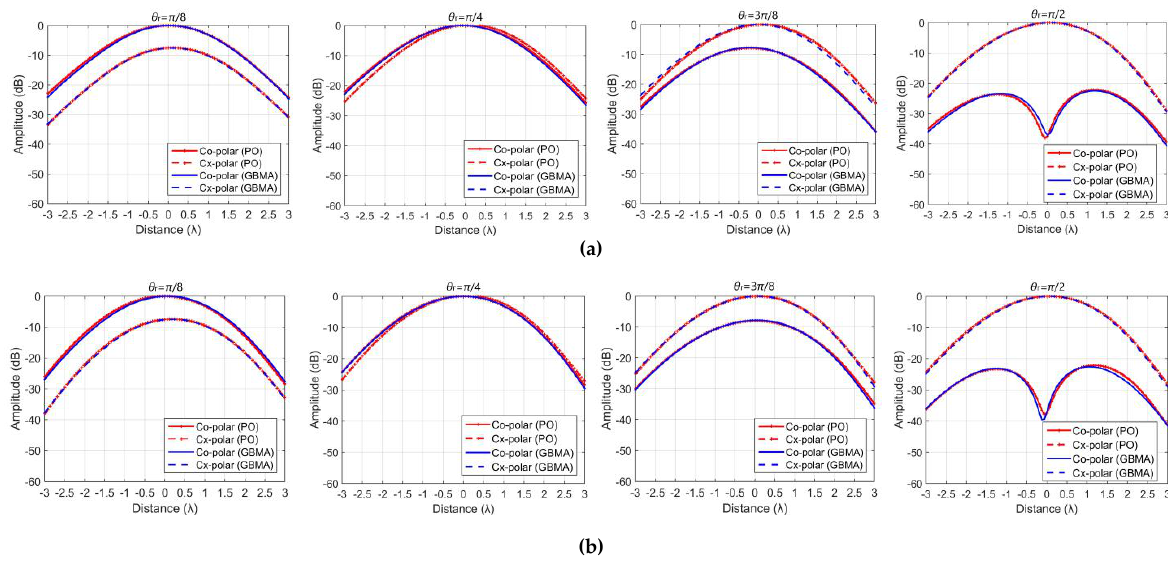
Figure 5. Amplitude distributions of 3-D systems with different θ r : ( a ) E-plane; ( b ) H-plane. PO refers to Physical Optics in GRASP10 and GBMA refers to Gaussian beam mode analysis proposed in this